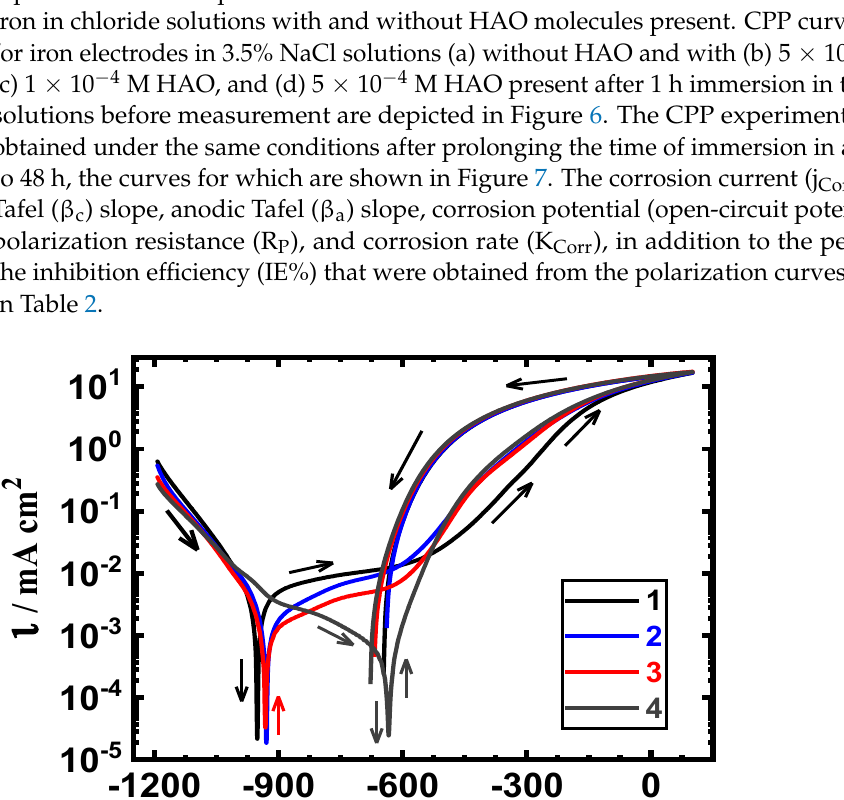
Figure 7. CPP curves for iron after 48 h immersion in (1) 3.5% NaCl solutions in the absence and presence of (2) 5 × 10 −5 M HAO, (3) 1 × 10 −4 M HAO, and (4) 5 × 10 −4 M HAO.